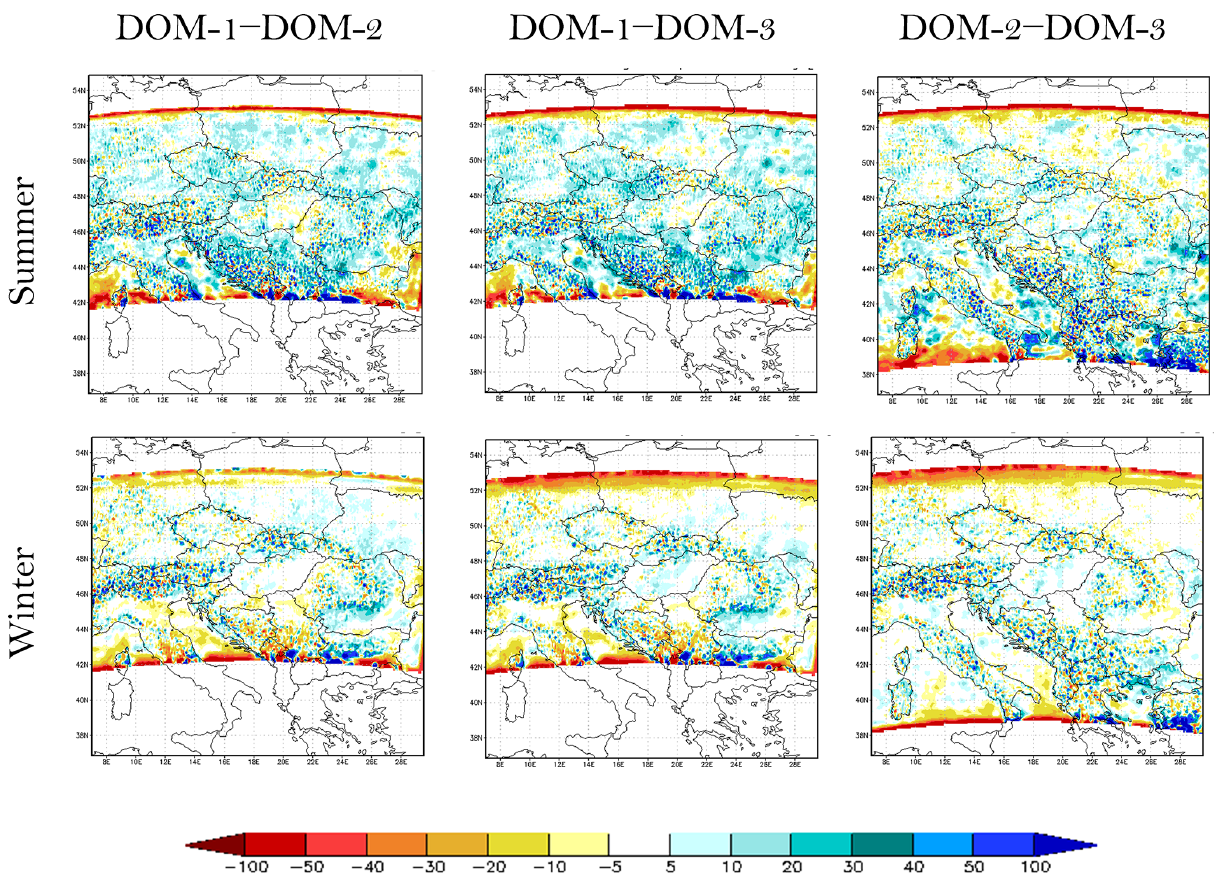
Figure 6. Relative difference (%) of the amount of summer and winter precipitation between the results of the experiments performed on different domains. Period: